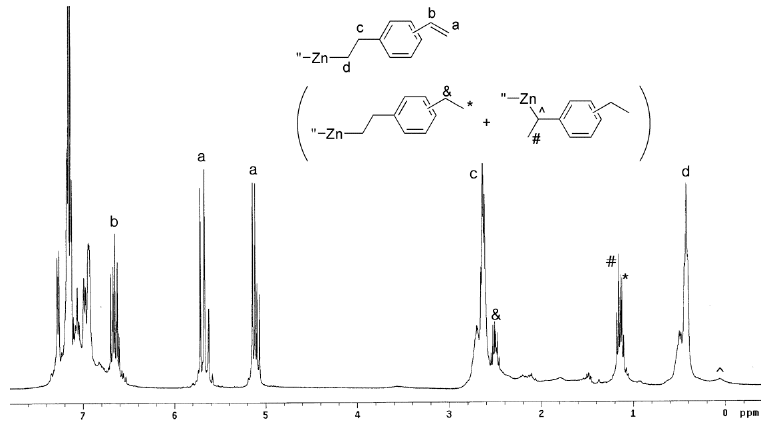
Figure 1. 1 H NMR spectrum of 3 in C 6 D 6 .